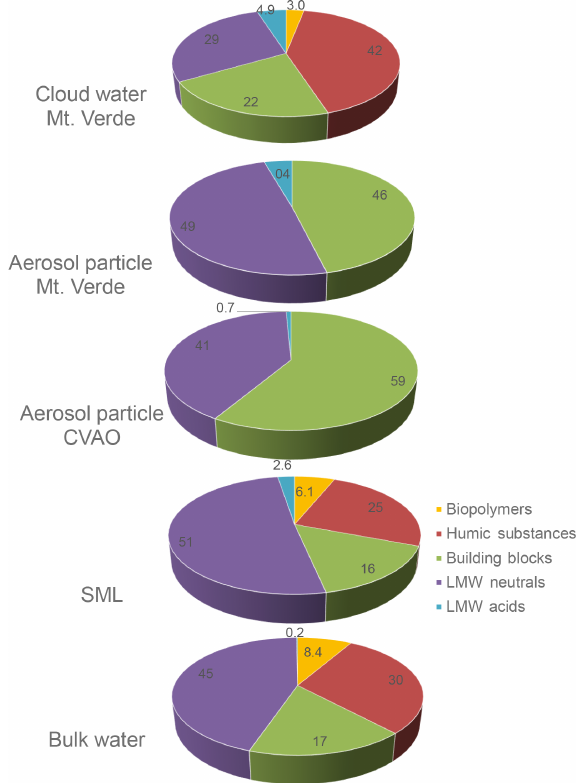
Figure 18. DOM classes measured in all compartments. The data represent mean values of three SML samples and the respective bulk water, three aerosol particle samples (PM 10 ) from the CVAO and two aerosol samples (PM 10 ) from Mt. Verde, and four cloud water samples, all collected during 26–27 September as well as 1–2 and 8–9 October